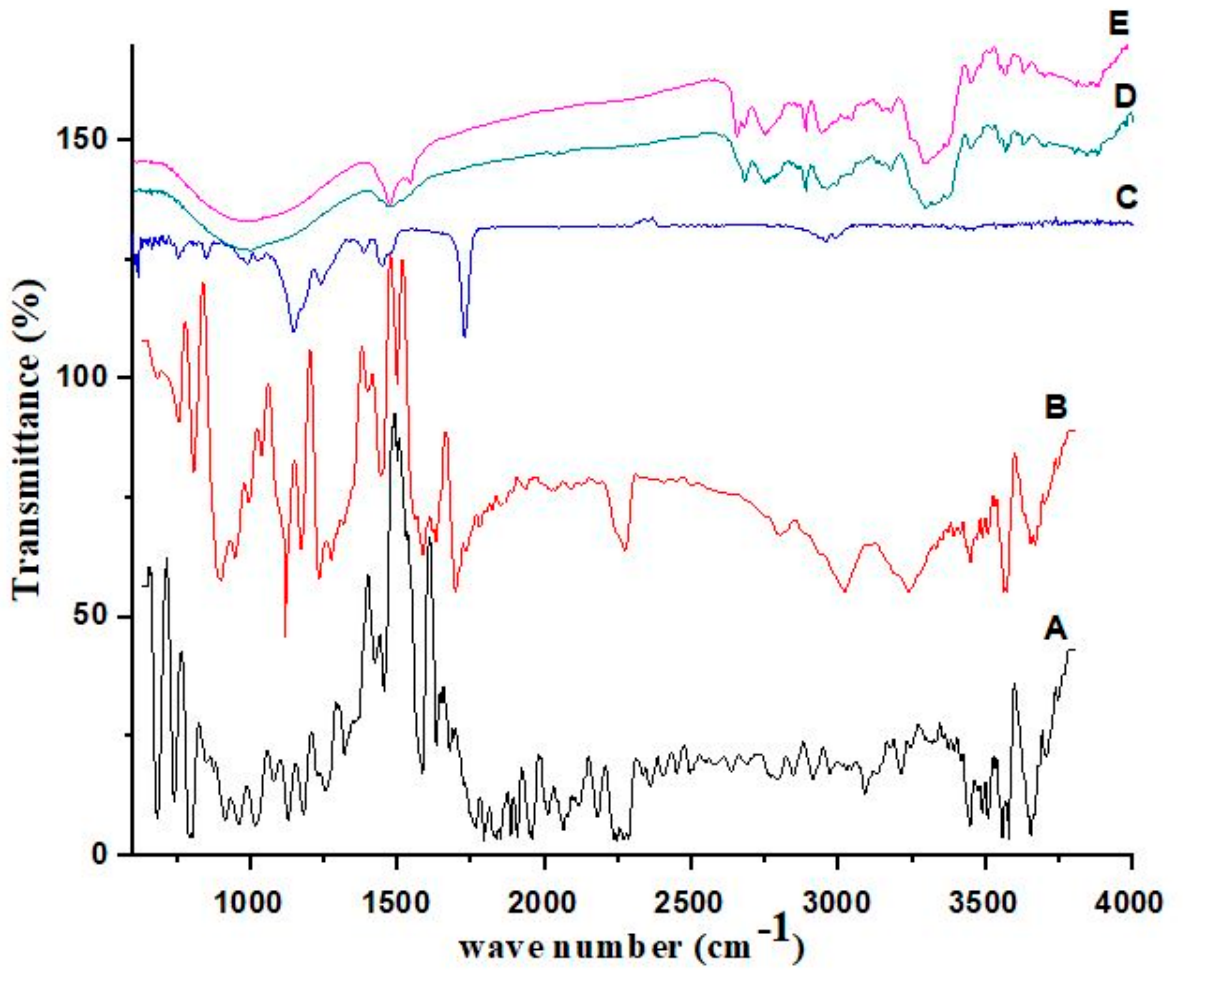
Figure 2. FTIR spectra of atorvastatin (A), ezetimibe (B), HPMC K-100 (C), formulation F1 (D) and F2 (E).